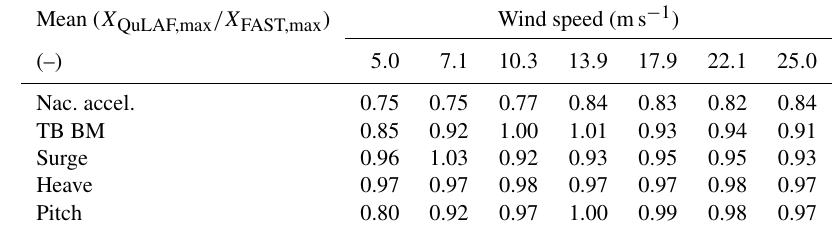
Table 7. Ratio of max. response (QuLAF / FAST) averaged per wind speed for DLC1.6. Mean ( X QuLAF,max /X FAST,max )